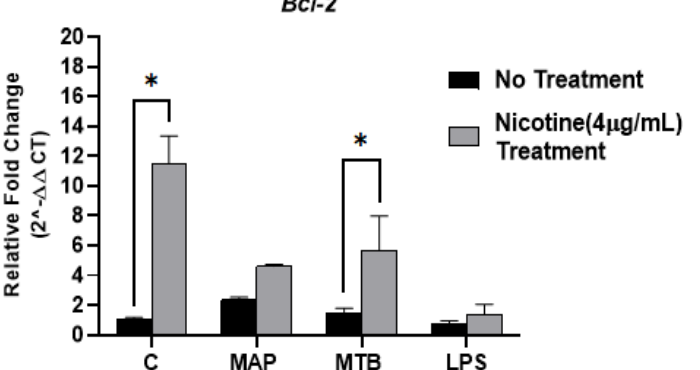
Figure 2. Effect of nicotine on the Bcl2 expression in infected macrophages. THP-1 PMA differentiated macrophages were infected with MAP and MTB, or treated with LPS for 24 h, then treated with nicotine (4 µg/mL). Expression of Bcl2 was measured by RT-PCR. All experiments were performed in duplicate. MAP: Mycobacterium avium paratuberculosis . MTB: Mycobacteria tubercalusis . LPS: lipopolysaccharide derived from Escherichia coli ATCC 8739. * p < 0.05.